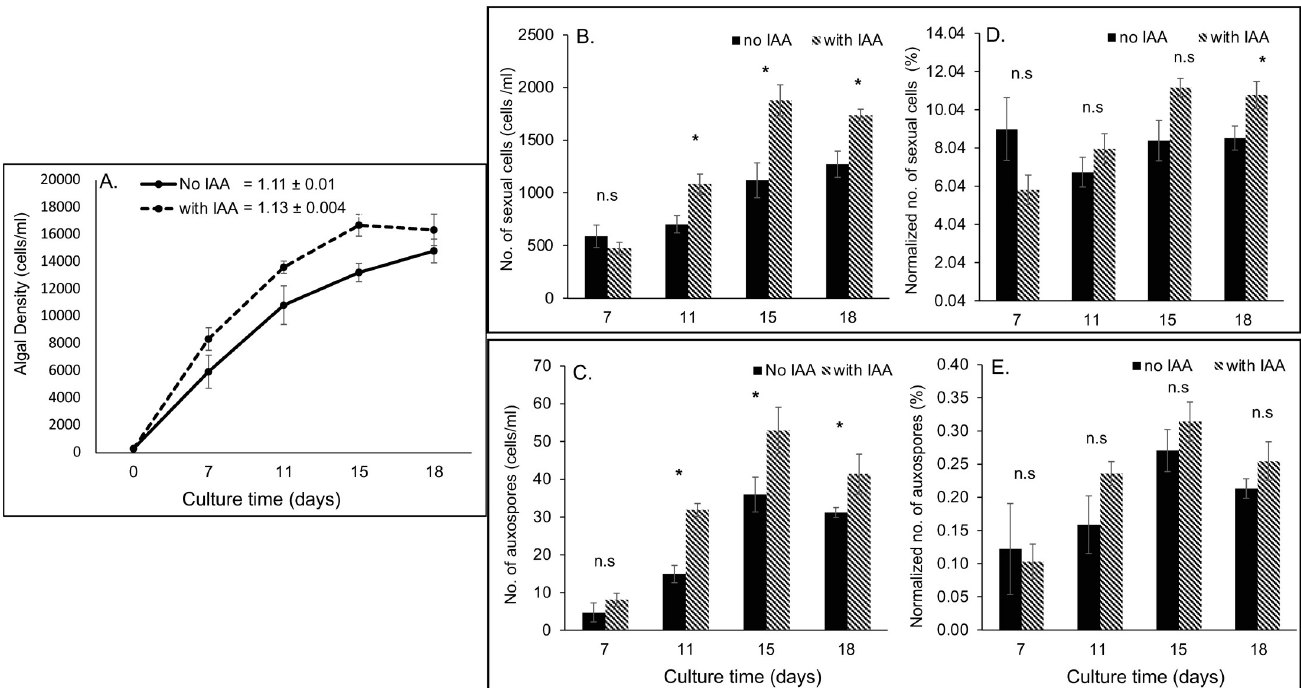
Fig 7. Growth and sexual reproduction of Odontella sp. cultures amended with and without IAA. ( A) Algal densities (B) Number of sexual cells. (C) Number of auxospores (D) Normalized number of sexual cells. (E) Normalized number of auxospores. Growth rate (A) was calculated between days 7 and 15. Group means (B-E) were compared for each time point using Paired T-test (n = 5 for each treatment). � denotes a statistical significance at p < 0.05 while n.s. denotes no statistical difference.